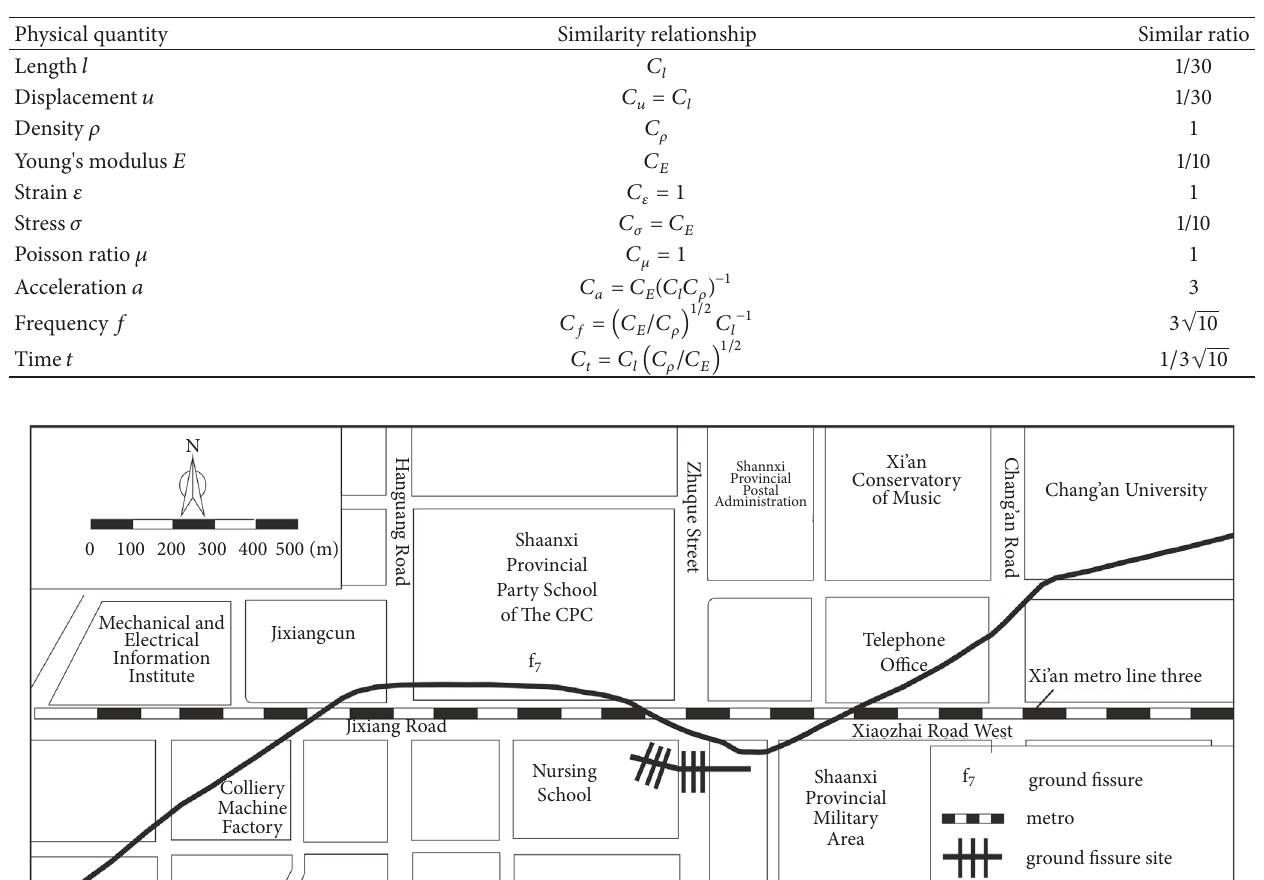
Table 2: Similar constants of shaking table model.